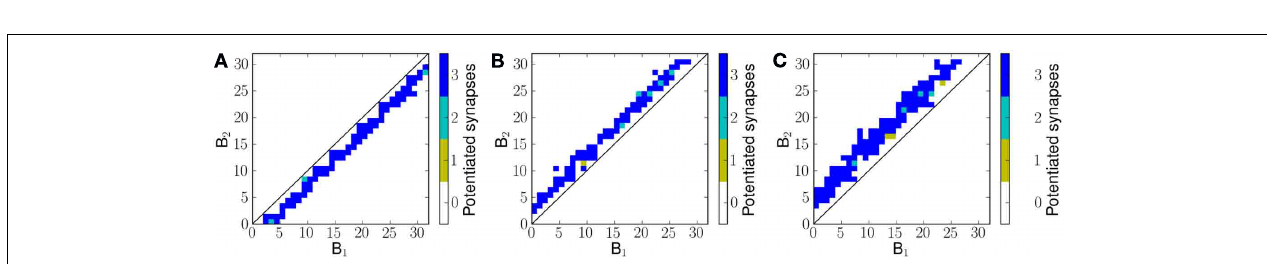
FIGURE 6 | (A) The distance, D , between spikes produced by neurons in population A and spikes arriving at neurons in population B 2 for a network exposed to a linear frequency sweep at velocity of 1.0ms − 1 . (B) Corresponding synaptic weight matrix showing the number of potentiated synapses per projection from B 1 to B 2 neurons.